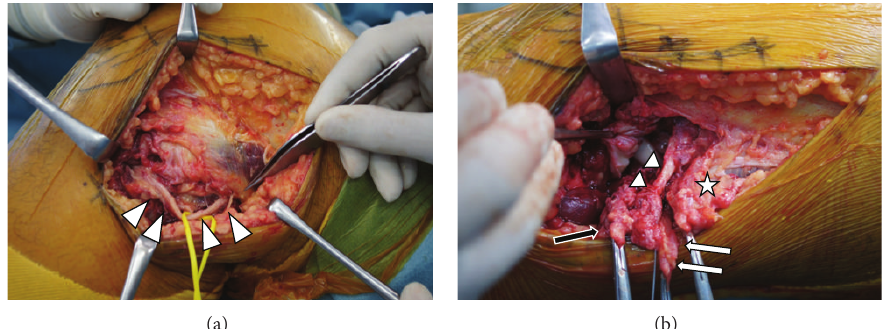
Figure 3: (a) There was evidence of contusion of the common peroneal nerve, and the patient underwent neurolysis (arrow head). (b) There were complete avulsions of the lateral collateral ligament (arrow), popliteofibular ligament (white arrow), and biceps femoris (star) from the fibula head; avulsion of the popliteus muscle tendon from the femoral condyle had also occurred (black arrow).